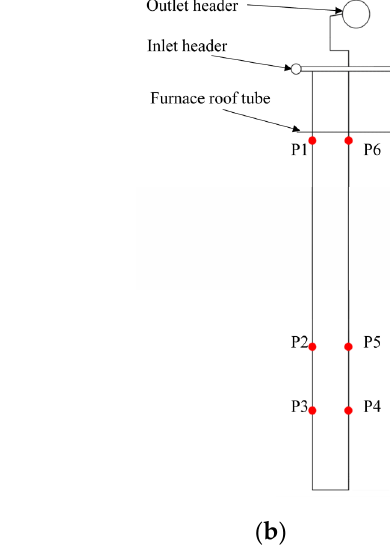
Figure 12. Tube wall temperature variation along the steam flow under two different load cases. The continuous 24-h on-line calculation results of the maximum tube wall tempera- ture (at the position of working fluid outlet) of the first serpentine on the 50th tube platen of the FSH are shown in Figure 13. As a peak regulation unit, the unit load changed within